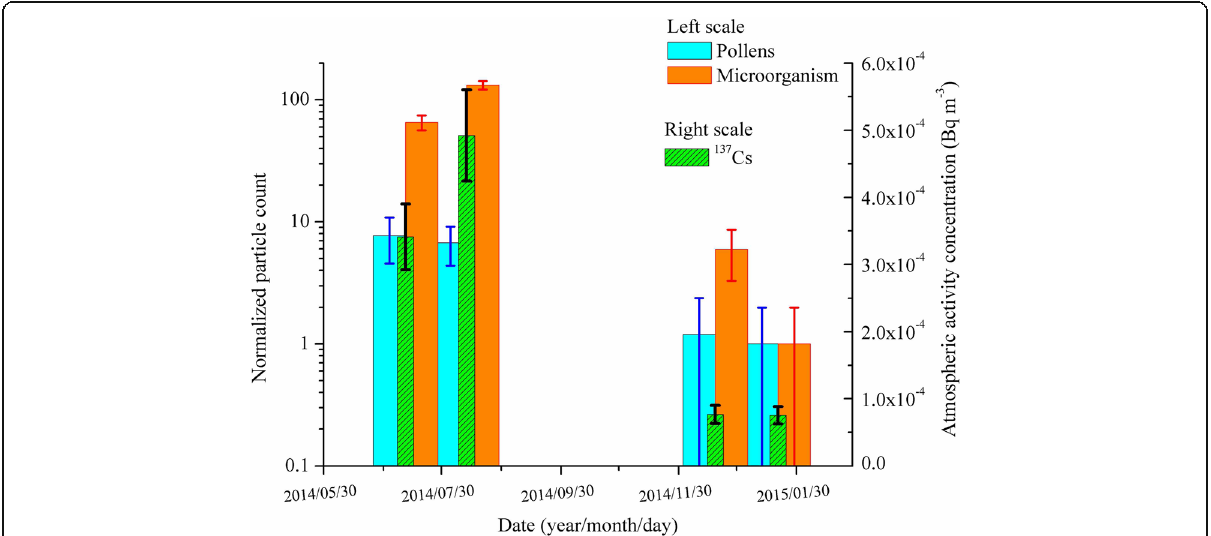
Fig. 12 The normalized particle count of the bioaerosols using SEM (in relative values, the error bar shows the Poisson standard deviation) and atmospheric concentrations of 137 Cs activity sampled at the GD site during summer (July and August 2014) and winter (December 2014 and January 2015). The counts of microorganisms include those of spores (see the